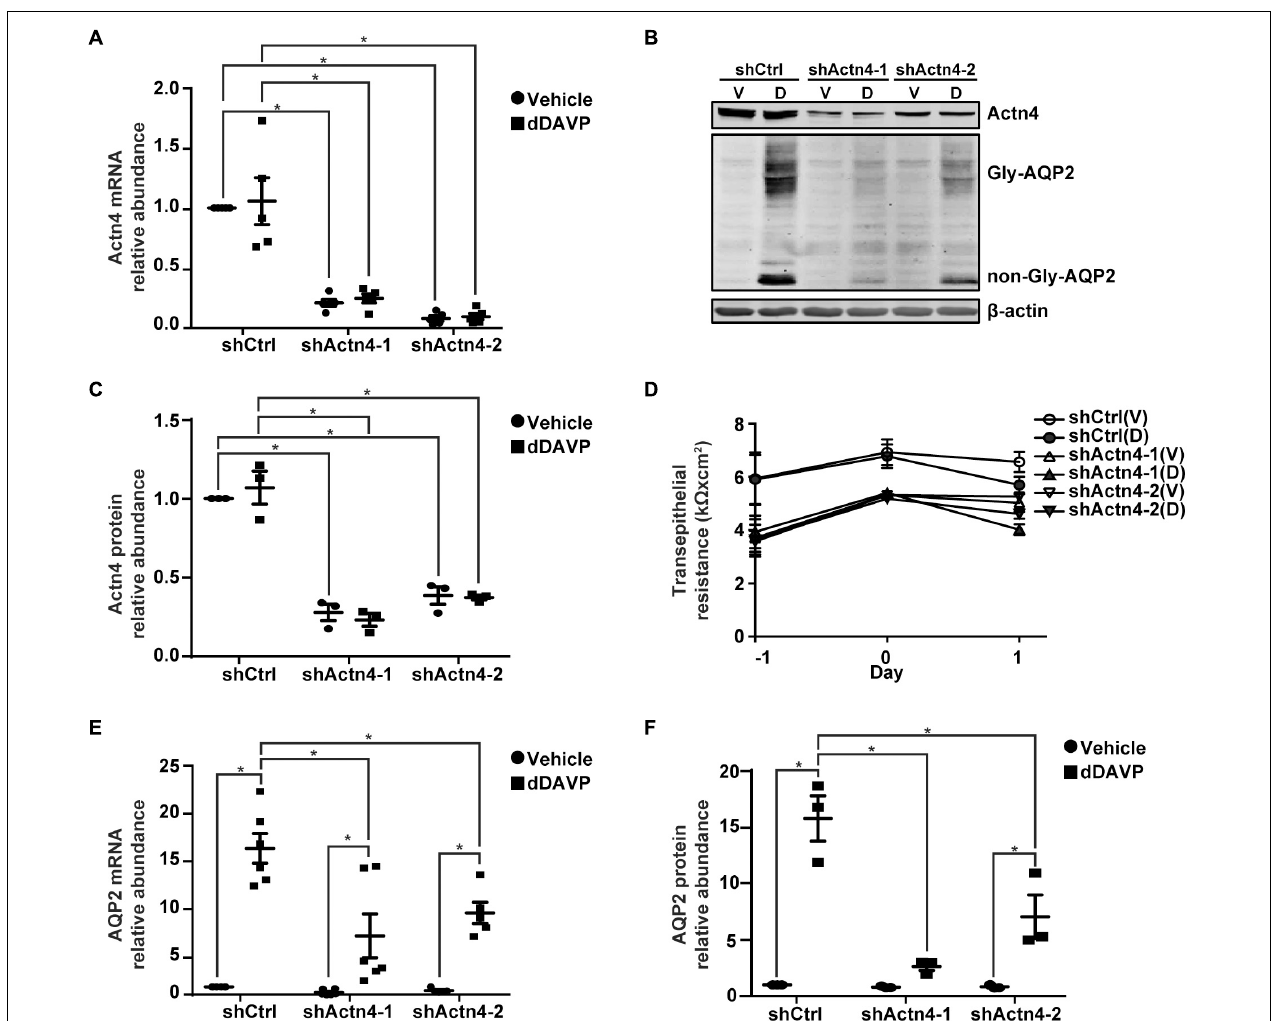
FIGURE 3 | α -actinin 4 knockdown reduced vasopressin-induced AQP2 gene expression in the mpkCCD cells. (A,E) Quantitative RT-PCR measurements of α -actinin 4 (Actn4) and AQP2 mRNA in control (shCtrl) and Actn4 knockdown (shActn4) cells exposed to vehicle (V) vs. 1 nM dDAVP (D). Two shActn4 sequences were used (shActn4-1 and shActn4-2). Numbers are means ± SEM, summarized from five or six independent experiments. Two-way ANOVA was used for statistical test. Asterisks indicate statistical significance between samples ( p < 0.05). (B,C,F) Representative immunoblots and summaries of Actn4 and AQP2 in shCtrl and shActn4 cells in response to vehicle vs. dDAVP. Gly-AQP2 and non-Gly-AQP2 are glycosylated and non-glycosylated AQP2, respectively. Numbers are means ± SEM, summarized from three independent experiments. (D) Transepithelial electrical resistance of the cells grown on Transwell R (cid:13) prior to vehicle vs. dDAVP stimulation. Day –1, cell polarization; day 0, dDAVP exposure; day 1, harvest for RNA/protein